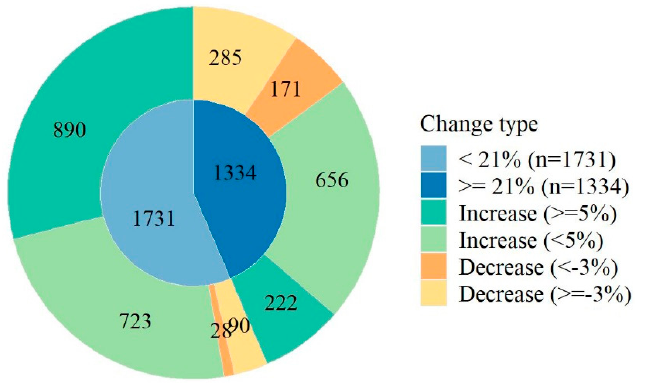
Figure 7. Difference in greenspace change during the period of 2005–2015 between neighborhoods with a higher than average greenspace accessibility in 2005 (21%) and all other neighborhoods.